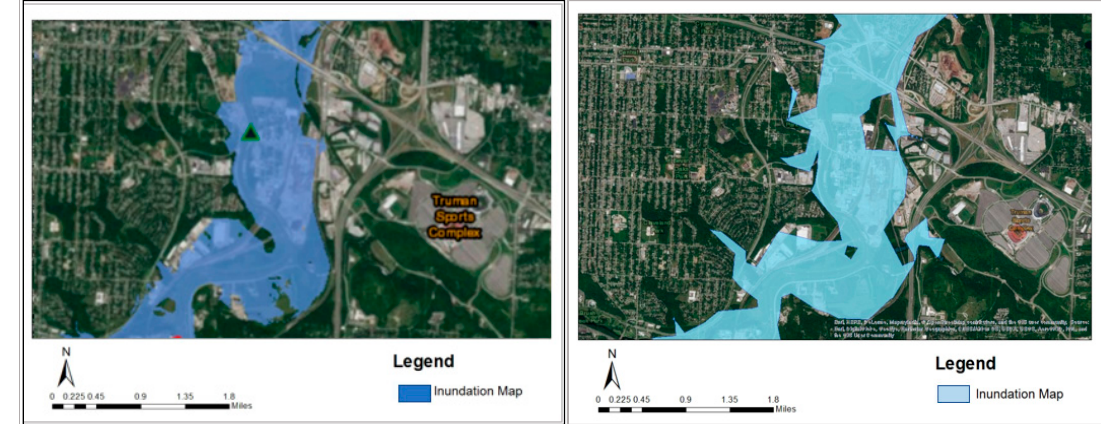
Figure 8. Comparison of the Inundation Map created by the HEC-RAS simulation ( right-side ) with the USGS ( left-side ) generated Inundation Map beside the Truman Sports Complex in Kansas City, MO.